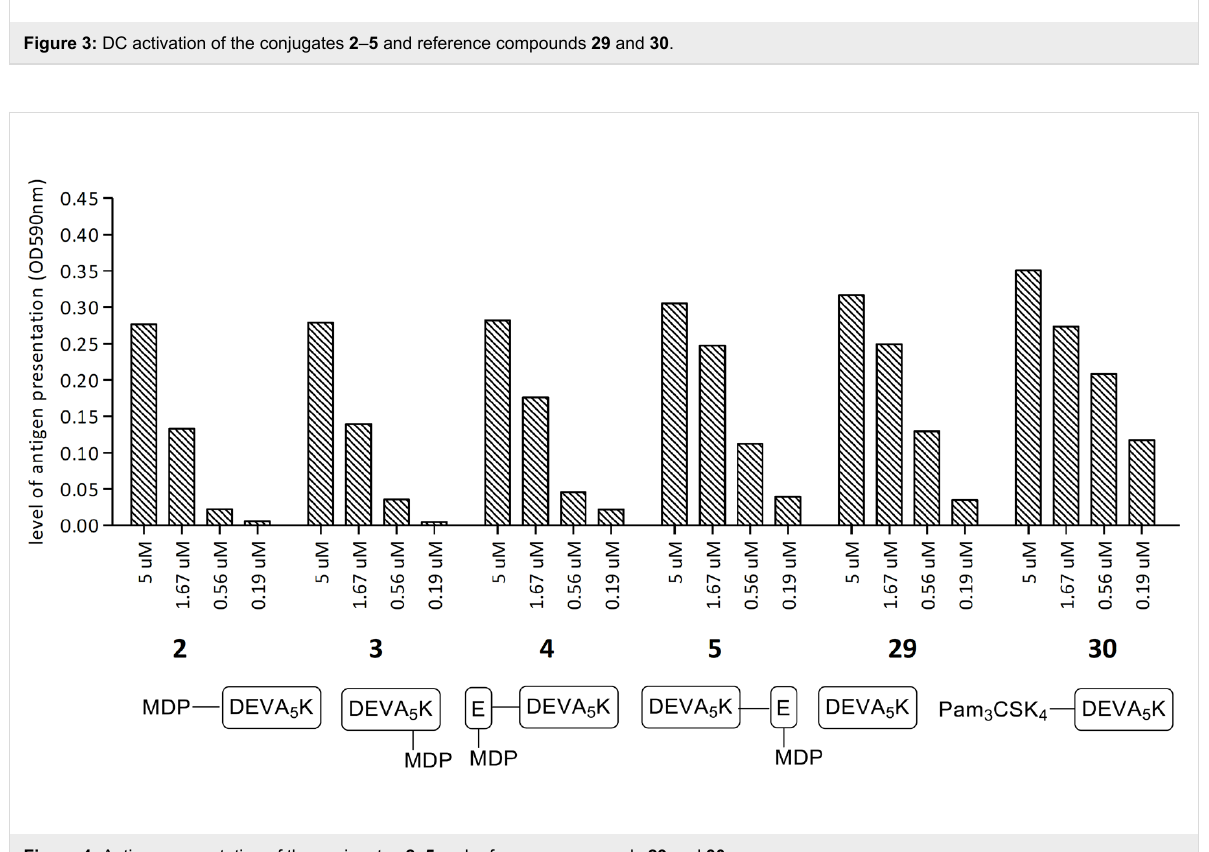
Figure 4: Antigen presentation of the conjugates 2 – 5 and reference compounds 29 and 30